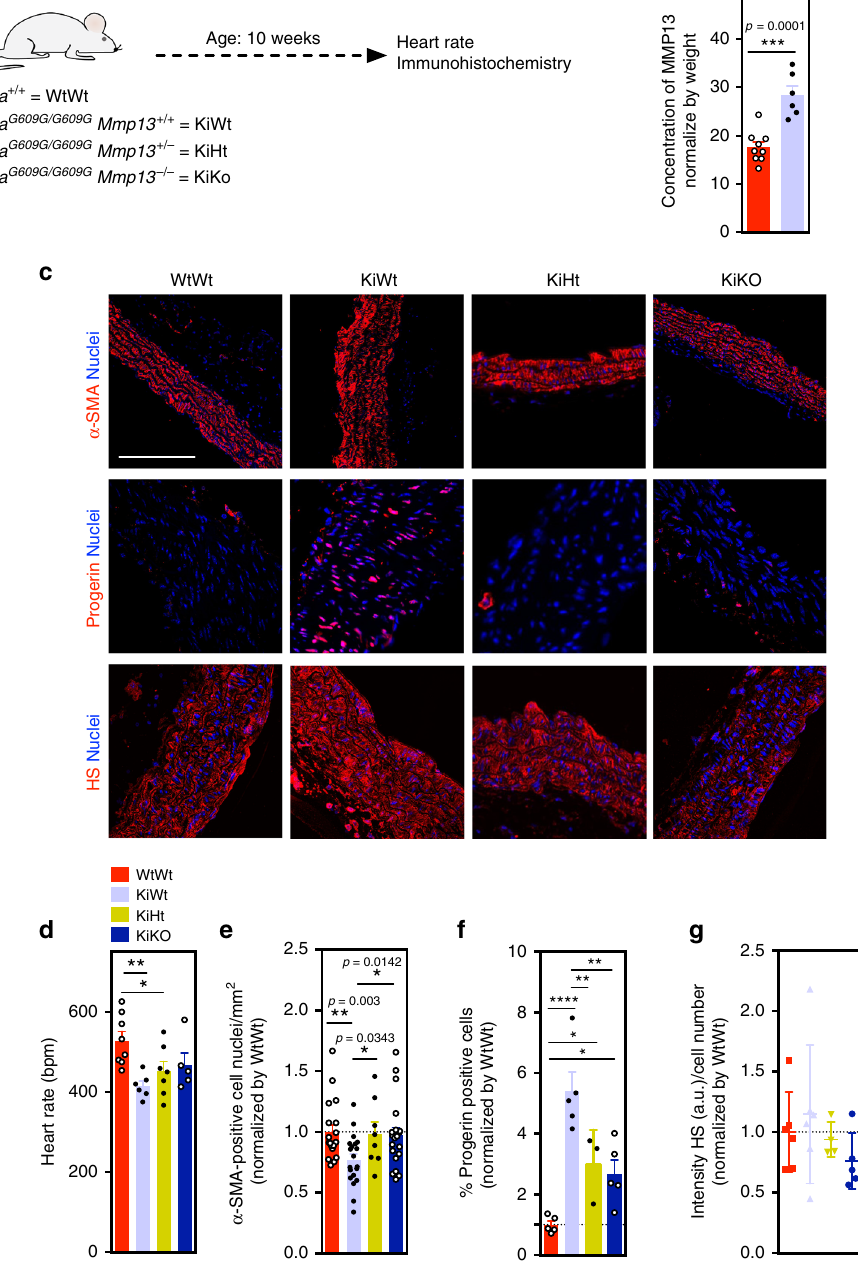
Fig. 5 MMP13 inhibition signi fi cantly increases SMC number in aortic arch of Lmna G609G/G609G mice. a Schematic representation of the animal protocol. WtWt, KiWt, KiHt, and KiKo mice (age: 10 weeks) were evaluated. b Quanti fi cation of MMP13 activity (plasma from WtWt, n = 9, and KiWt, n = 6, mice) by ELISA. Fluorescence signal was normalized by mice weight. Statistical analyses were performed by a two-tailed unpaired Student ’ s t test. c Immuno fl uorescence analyses in the aortic arch for α -SMA, progerin, and heparan sulfate (HS). Cell nuclei were stained with DAPI. Scale bar is 100 µ m for α -SMA staining and 50 µ m for progerin and heparan sulfate staining. For α -SMA staining, n = 5 animals, except for KiHt (four animals). For progerin staining, n = 5 animals, except for KiHt (three animals). For heparan sulfate n = 6 WtWt, n = 6 KiWt, n = 4 KiHt, and n = 5 for KiKo. d Heart rates in mice ( n = 8 WtWt, n = 6 KiWt, n = 7 KiHt, and n = 5 KiKo). Statistical analyses were performed by one-way ANOVA followed by Newman – Keuls ’ s post test. e Number of SMC nuclei in aortic arch per tissue area (mm 2 ) ( n = 2 – 3 slides examined over fi ve animals, except for KiHt (four animals)). Statistical analyses were performed by a two-tailed unpaired Student ’ s t test. f Percentage of progerin-positive cells in SMCs. n = 5 animals, except for KiHt (three animals). Statistical analyses were performed by one-way ANOVA followed by Newman – Keuls ’ s post test. g Expression of heparan sulfate as evaluated by immuno fl uorescence. Intensity of heparan sulfate was calculated in each picture (at least 16 pictures per condition) and normalized by cell number mice ( n = 6 WtWt, n = 6 KiWt, n = 4, KiHt and n = 5 KiKo). In b , d – g , results are mean ± SEM. *, **, ***, **** denote statistical signi fi cance ( p < 0.05, p < 0.01, p < 0.001, p <